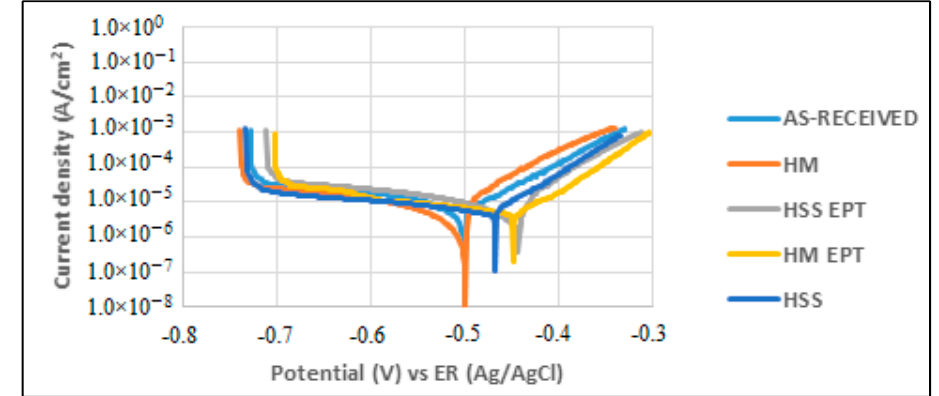
Figure 5. Polarization curves at 0 h.